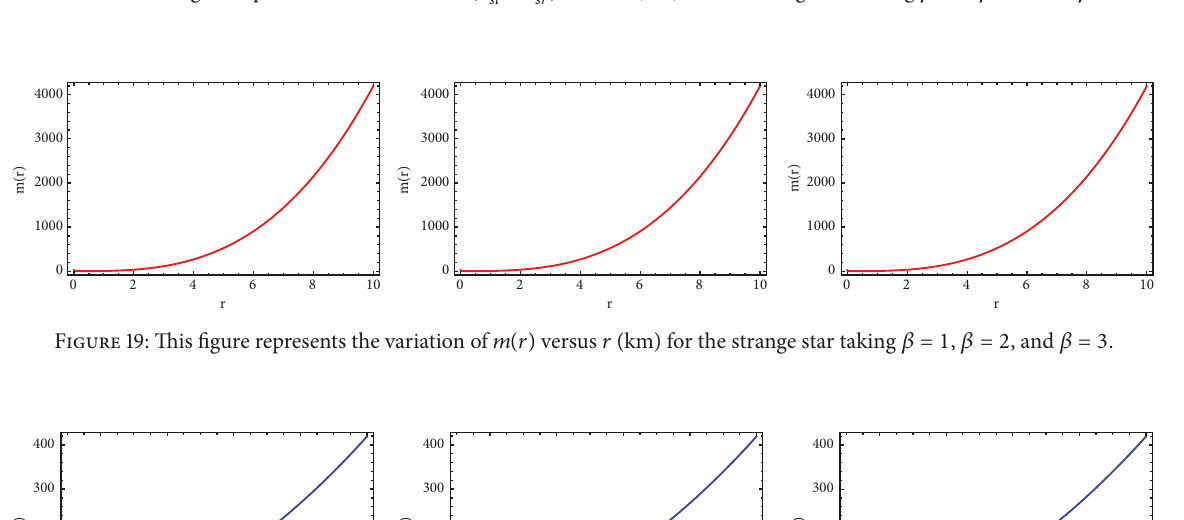
0.50 0.55 0.60 0.65 0.70 0.75 Figure 18: This figure represents the variation of | V 2 𝑠𝑡 − V 2 𝑠𝑟 | versus 𝑟 (km) for the strange star taking 𝛽 = 1 , 𝛽 = 2 , and 𝛽 = 3 .